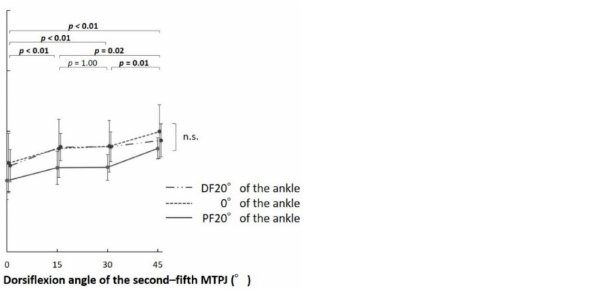
Figure 4. Comparison of the maximal voluntary contraction (MVC) torque of the second–fifth metatarsophalangeal joint (MTPJ) at different MTPJ positions. The torque-angle relationship corre- sponds to the ascending limb at dorsiflexed (DF) 0–45 ◦ of the second–fifth MTPJ when the ankle was at plantar-flexed (PF) 20 ◦ , neutral (0 ◦ ), and DF20 ◦